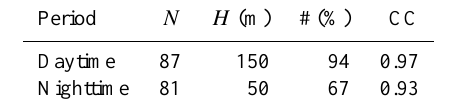
Table 1. Statistics for the comparison between MLH estimated from lidar and radiosonde observations (adapted from Pal et al., 2013). The number of radiosonde measurements used (N), the height con- sistency interval considered (H), the number of cases (%) where lidar and radiosonde MLH retrieval differences are less than H (#), and correlation coefficient (CC) are reported. Period N H (m) # (%) CC Daytime 87 150 94 0.97 Nighttime 81 50 67